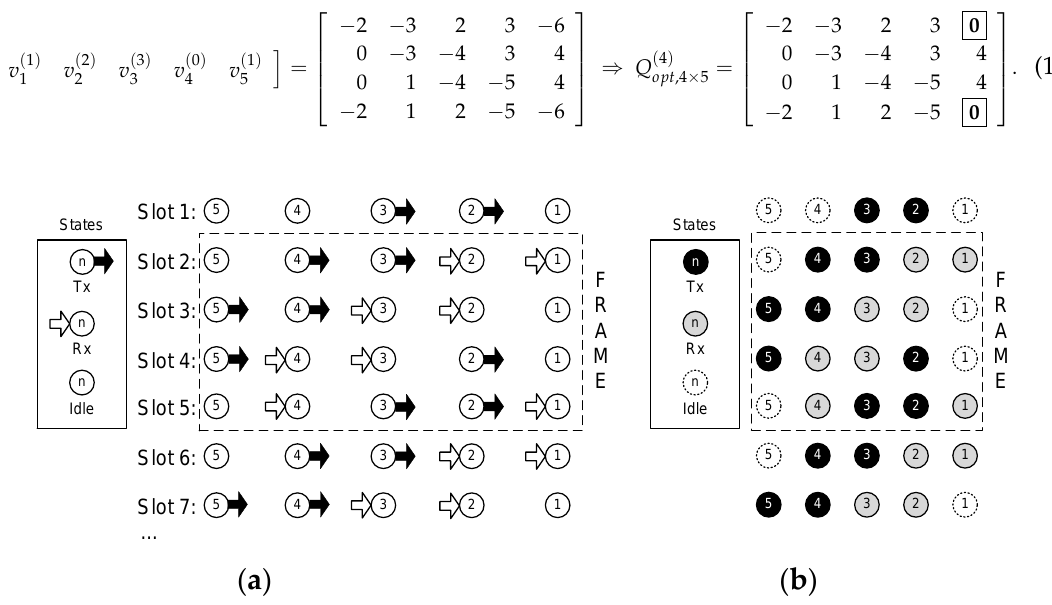
Figure 5. ( a ) State diagram for the optimal schedule in a string network with 𝑁 = 5 . An equivalent but more convenient representation to apply a geometrical method is shown in ( b ).